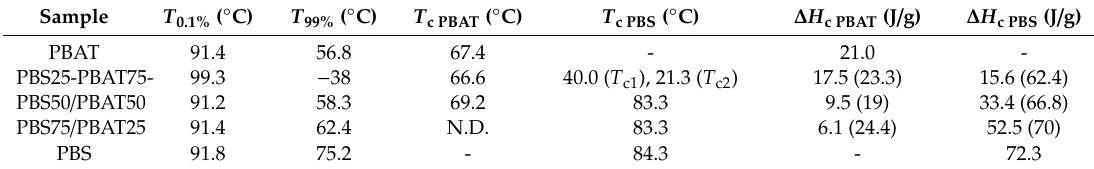
Figure 3. DSC thermograms of PBS, PBAT and their blends: ( a ) cooling from the melt, ( b ) relative crystallinity vs. temperature. Table 1. DSC results for PBS, PBAT and their blends during the cooling from melt. The values of crystallization enthalpy in parentheses are normalized with respect to the weight fraction of the polymer in the blends.